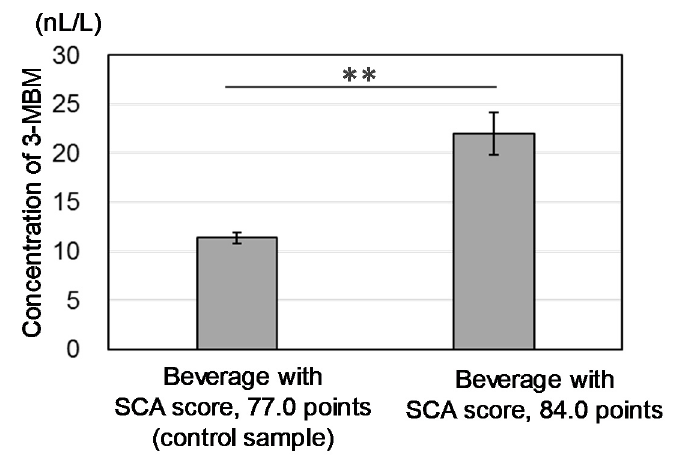
Figure 2. Quantitative analysis of 3-MBM in coffee brews from two different quality coffee beans. Statistical significance is indicated by the Student t test (** p < 0.01).